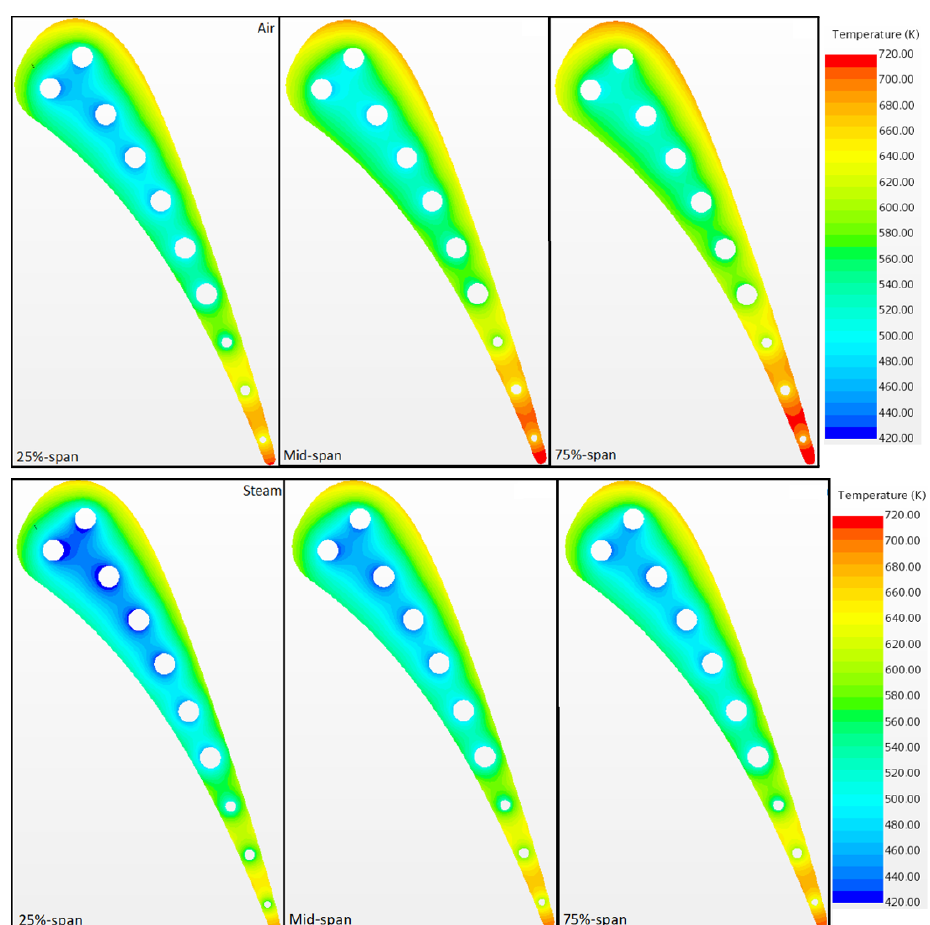
Figure 10. Temperature contour comparison of the different cross-sectional